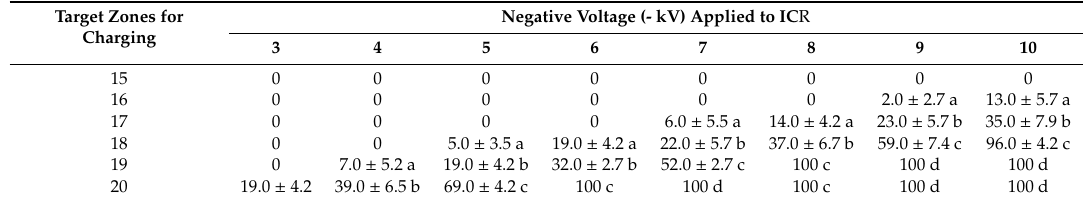
Figure 4. ( A ) Constant electric current by silent discharge of an insulated copper ring (ICR), ( B ) transient electric current from insect discharge (at − 10 kV) or insect discharge plus constant discharge of ICR (at − 12 and − 14 kV), and ( C ) comparison of insect discharge-mediated transient electric currents in zone 20 at di ff erent voltages and ( D ) in di ff erent zones of an aluminum pole exposed to − 10 kV-charged ICR. A: ICR was negatively charged with − 10, − 12, and − 14 kV in the absence of insects on the pole. B: ICR was charged immediately after the insect entered the target zone. Arrow represents the timing of charging. C: ICR was negatively charged at − 7 to − 10 kV when the insect entered the target zone (zone 20). D: ICR was negatively charged at -10 kV when the insect entered the target zones. In C and D, twenty adult insects were used per experiment, and the means and standard deviations were calculated from five experimental replicates. The letters (a–d) on each column indicate significant di ff erences ( p < 0.05) according to Tukey’s method. Table 1. Percentage of adult rice weevils attracted to the insulated ring-shaped copper rod (ICR), which was negatively charged with di ff erent